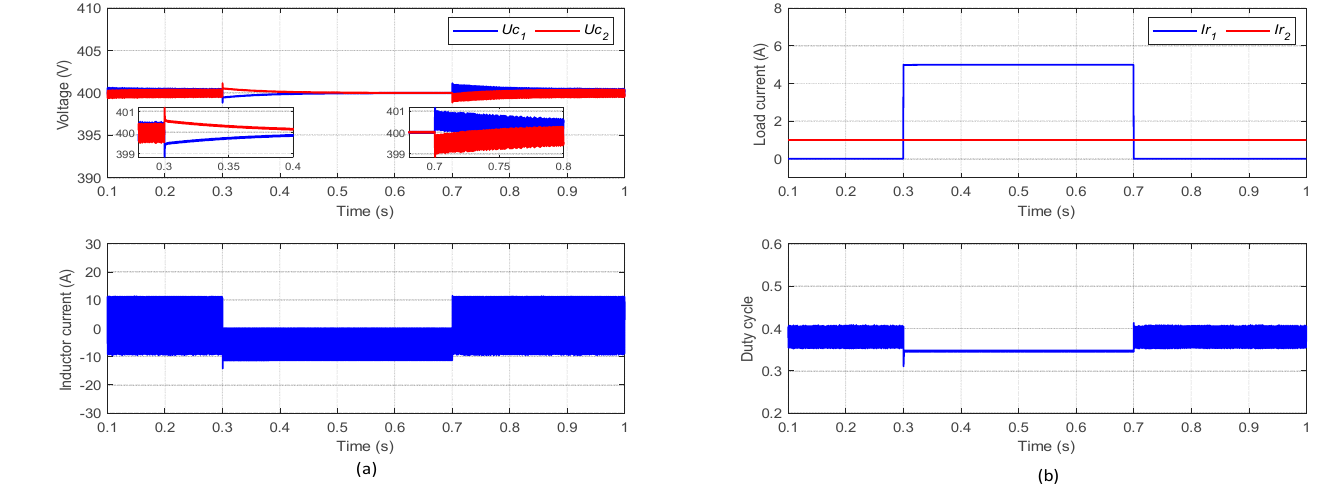
Figure 11. I R 1 Load transient response using the GA–PI controller. ( a ) Inductor current and output Figure 11. 𝐼 𝑅1 Load transient response using the GA – PI controller. ( a ) Inductor current and output voltages. ( b ) Duty cycle and load voltages. ( b ) Duty cycle and load current.